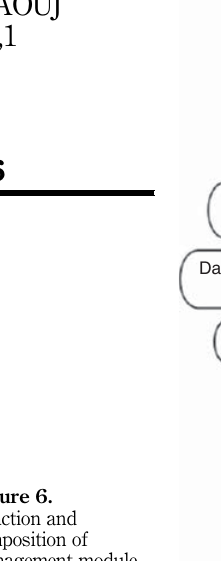
Figure 6. Function and composition of management module